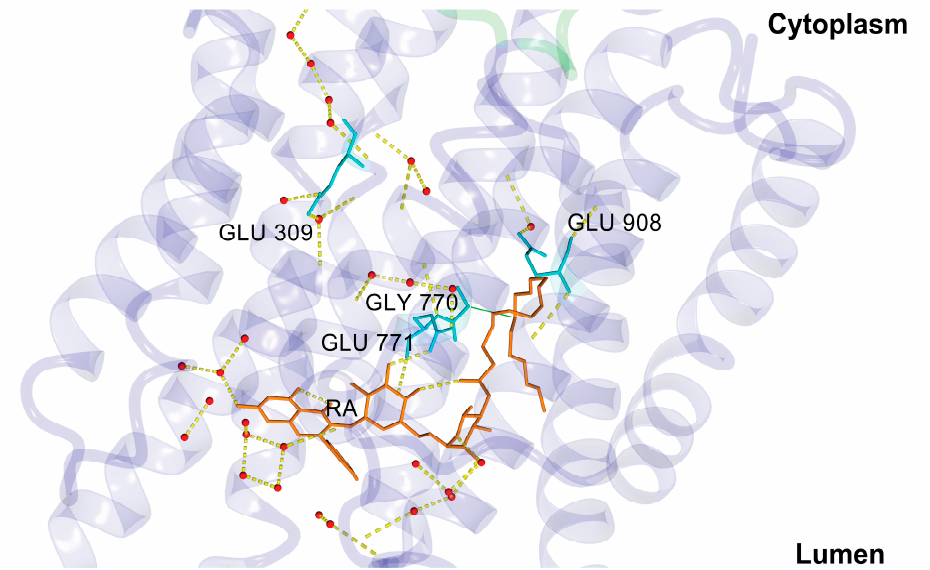
Figure 10. Water network for proton pathway from the lumen to the cytoplasm. Proton pathway was created, but proton transfer was not probable due to high values of pK a ’s. RA—stick model (in orange); Ca 2 + transport site residues—stick model (in cyan). Hydrogen bonds are displayed as yellow dashed lines. Water molecules are depicted as red spheres. Figure was rendered using YASARA [42].